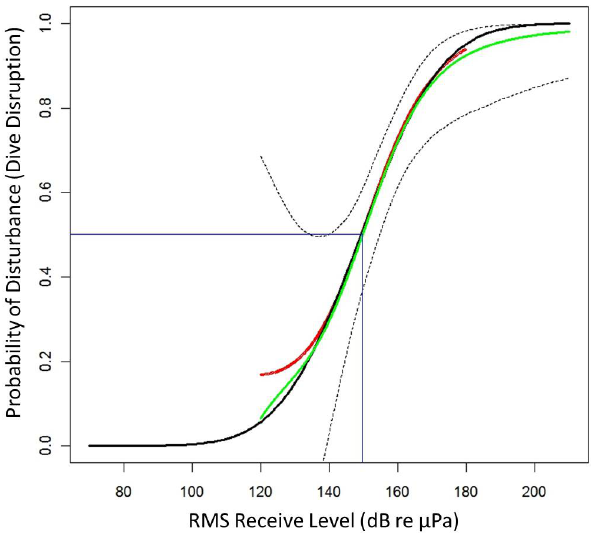
Figure 2. The probability of disturbance ( D rms ) as a function of sonar RL rms . The GAM fit to the recorded data is shown in red with the bootstrap mean shown by the green with the point-wise 95% confidence limits indicated by dotted lines from the bootstrap. The parametric GLM approximation is shown in black. There is a.5 probability of disturbance at a RL rms of 149.8 dB; this is indicated in blue.